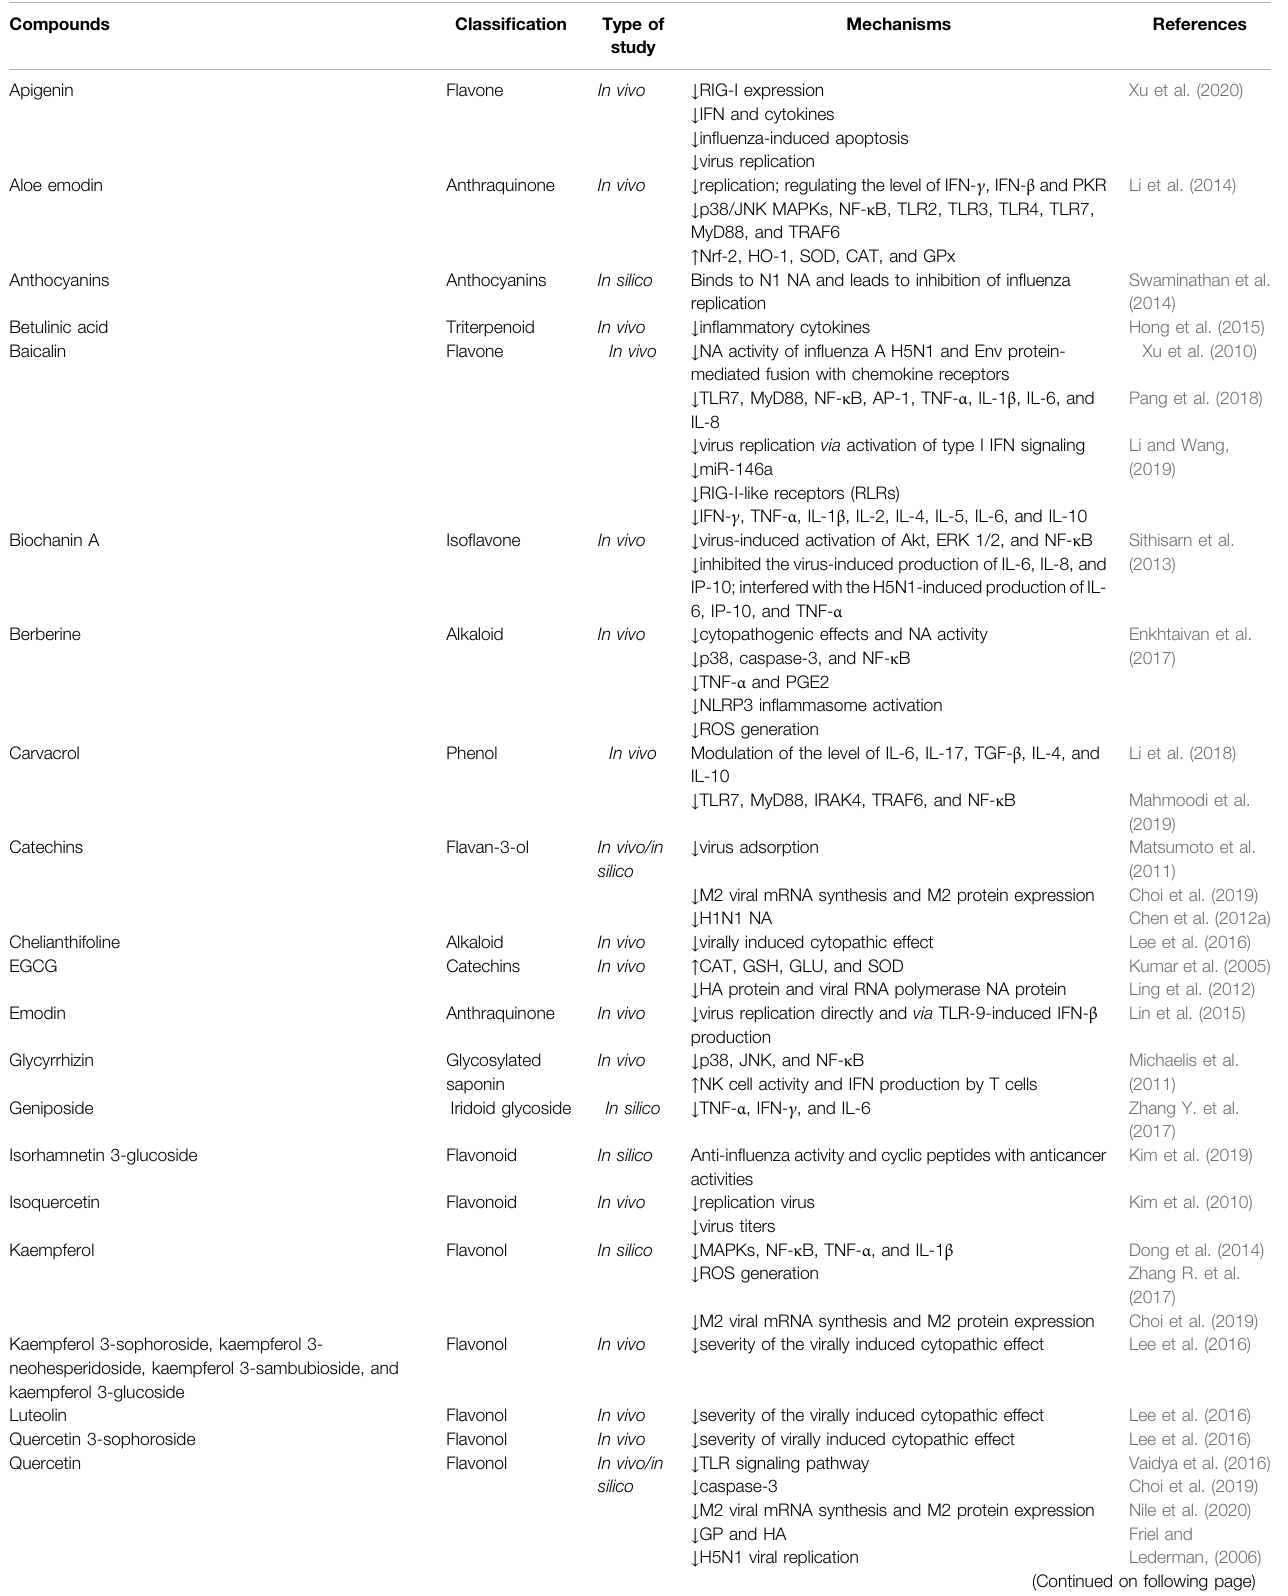
TABLE 1 | Preclinical evidence on the use of candidate phytochemicals against in fl uenza virus and related neuropharmacological